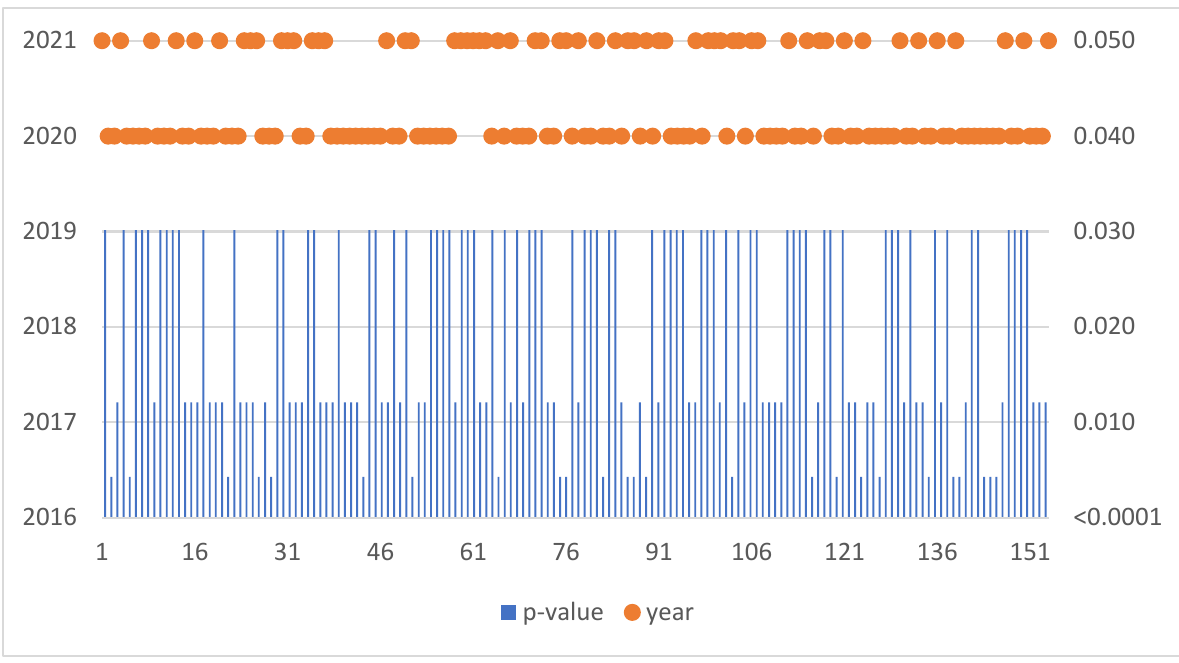
Figure 9. Heterogeneity in Slovakia. Table 4. Years of disruption for